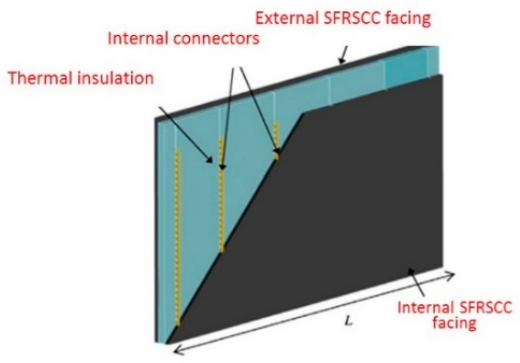
Figure 22. Components of the proposed devised load-bearing composite panel. Adapted from [70].